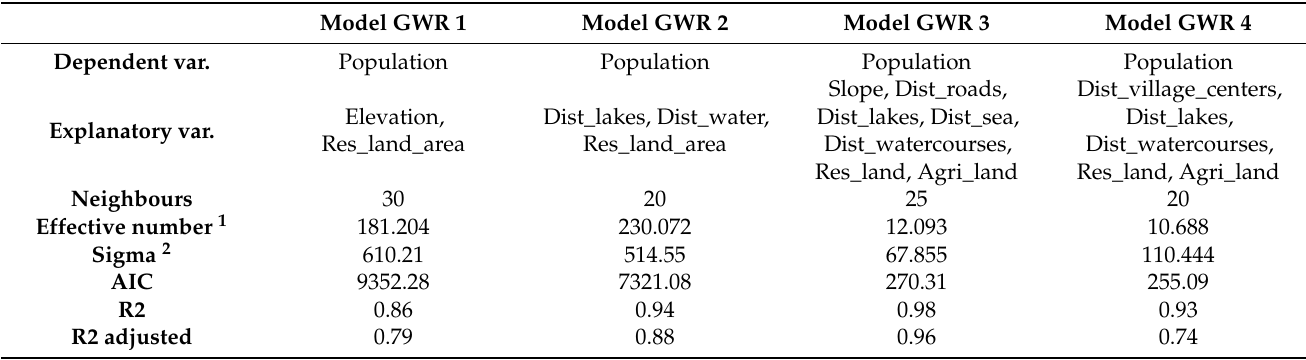
Table 4. Statistics from the GWR model